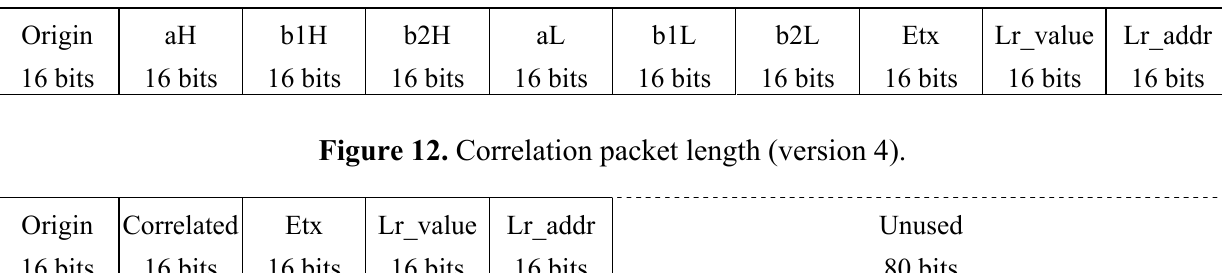
Figure 11. Coefficients packet length (version 4).